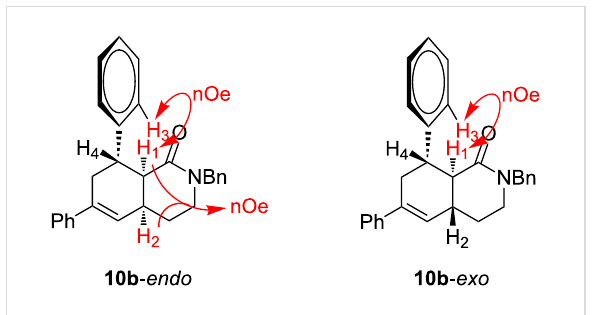
Figure 1: Determination of the relative stereochemistry on com- pounds 10b